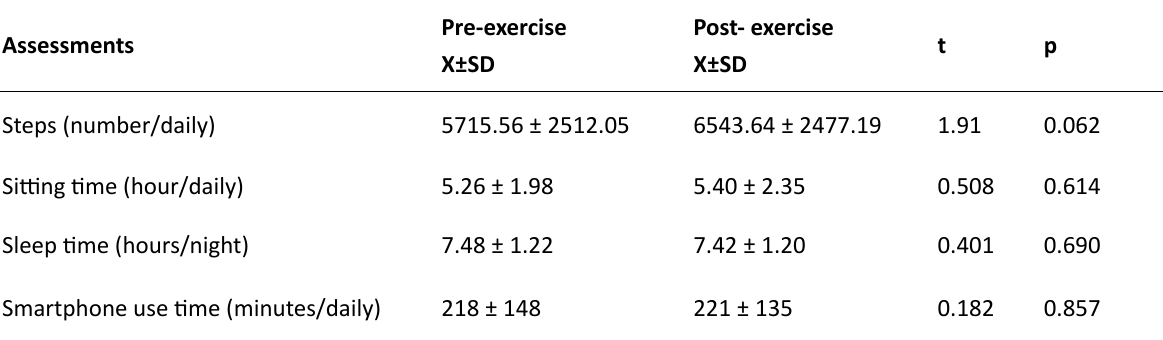
Table 4. The comparison of the assessments before and after the 5x5 exercise program